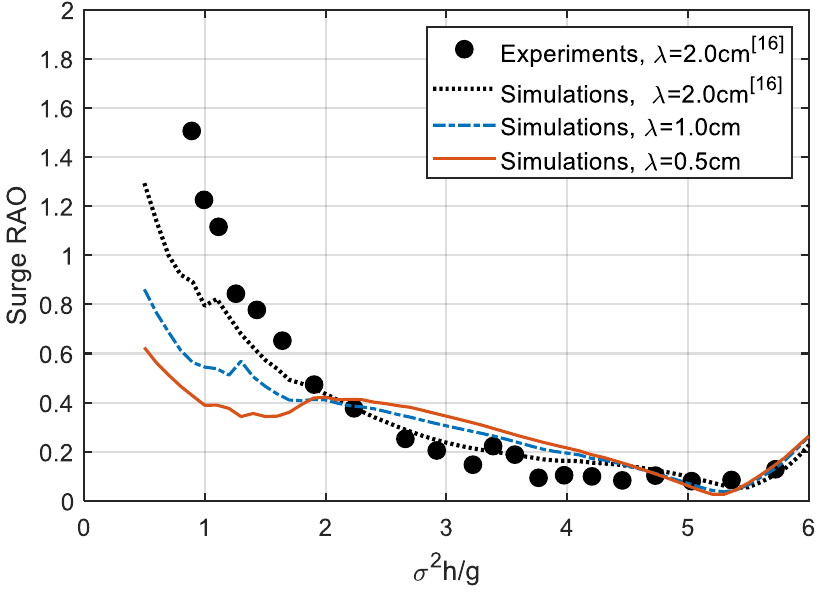
Figure 2. Comparison of the surge response amplitude operator (RAO) for the platform with various fishnet mesh sizes.